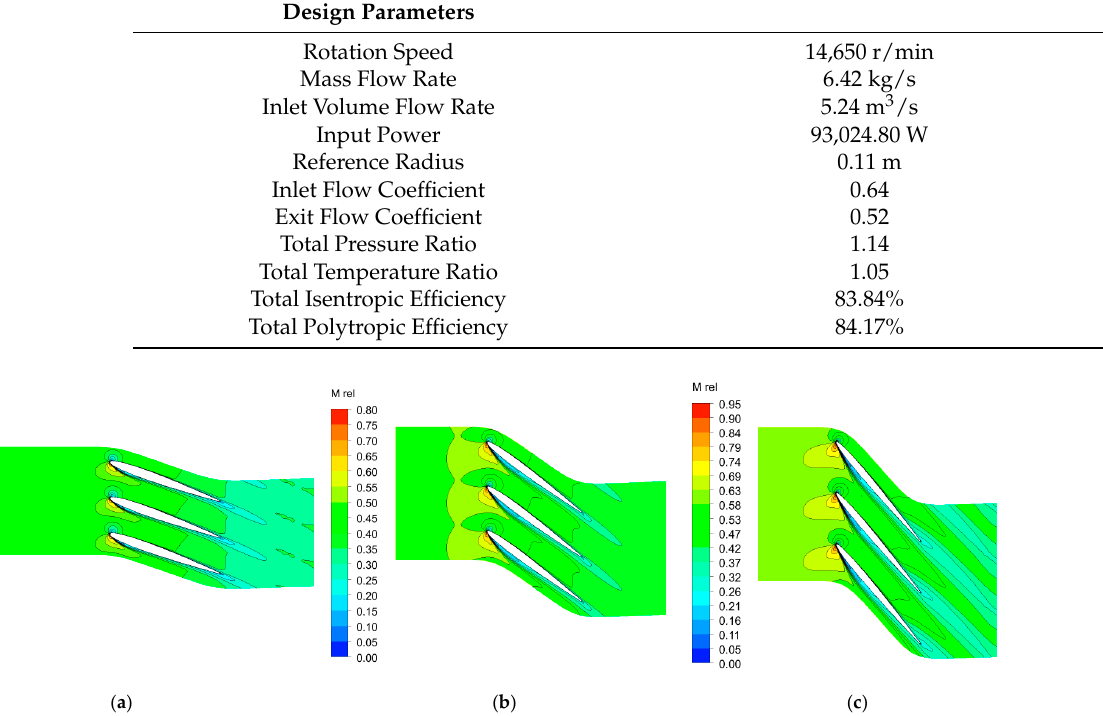
Aerospace 2023 , 10 , x FOR PEER REVIEW Figure 5. Mach number contours at 20% ( a ), 50% ( b ) and 80% ( c ) spans. Figure 5. Mach number contours at 20% ( a ), 50% ( b ) and 80% ( c ) spans.